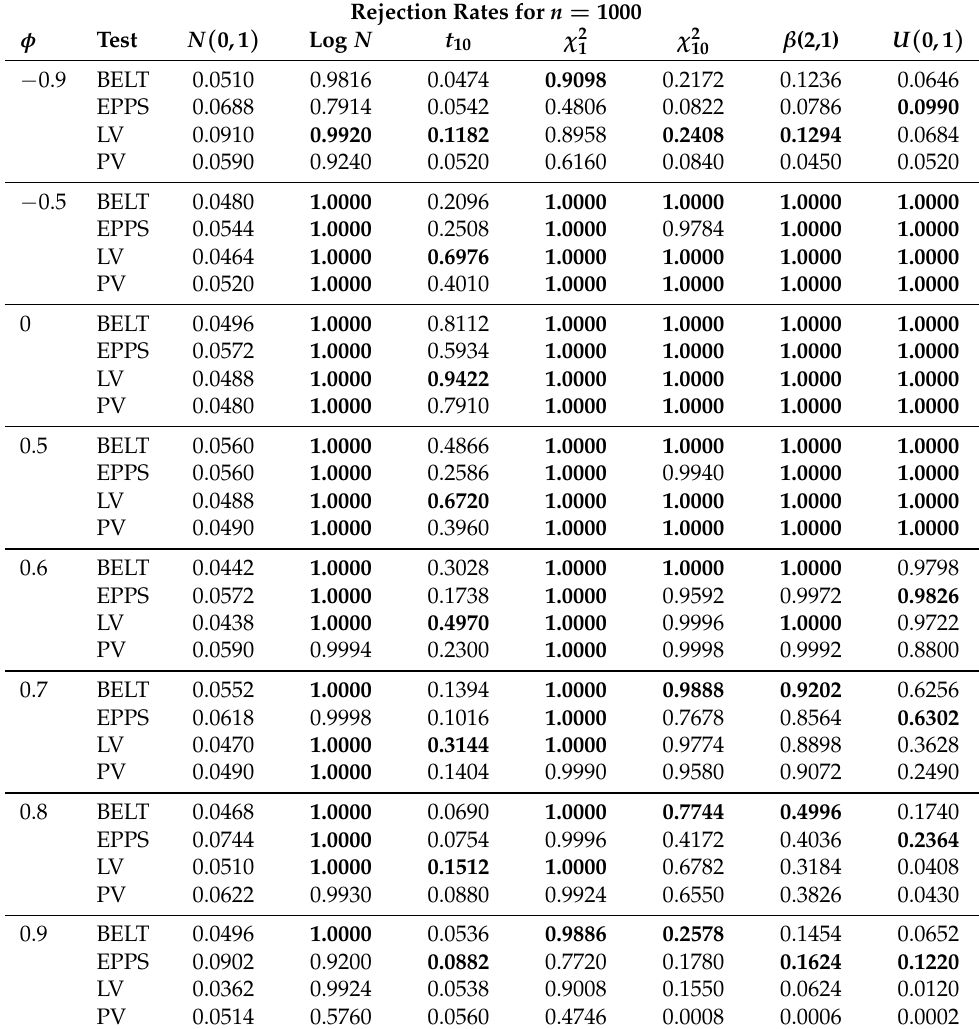
Table 6. Empirical rejection probabilities of the process defined in (10) at the 0.05 nominal level for n = 1000 using 5000